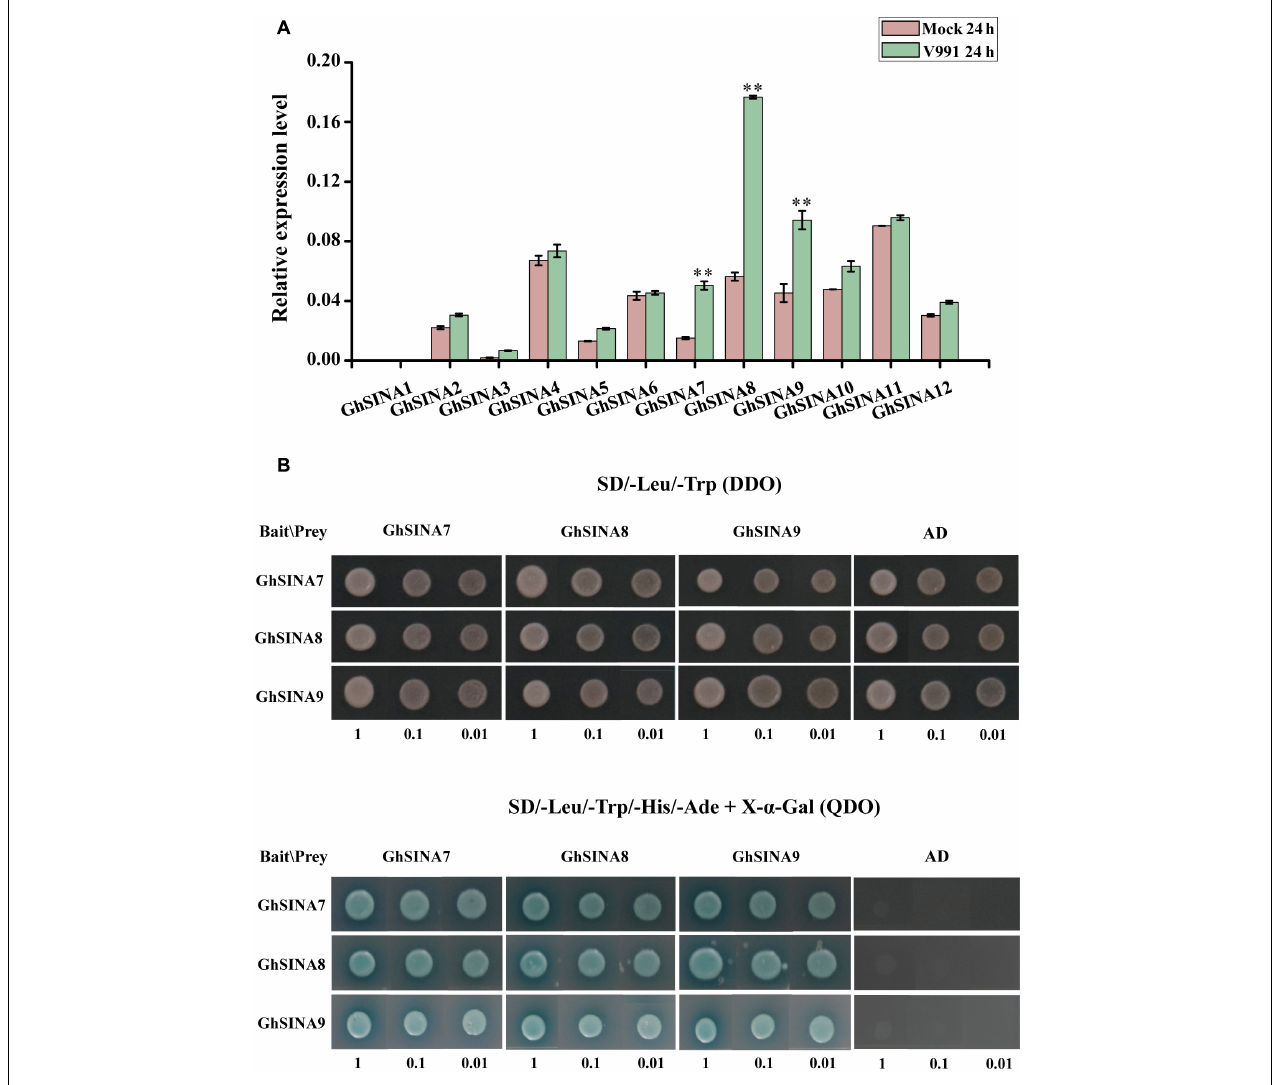
FIGURE 2 | Expression and yeast two-hybrid analyses of GhSINAs . (A) Expression levels of SINA genes in the resistant cultivar G. hirsutum cv. Zhongzhimian No. 2 roots at 24 h after inoculation with V. dahliae . Total RNAs were extracted from roots of 14-day-old seedlings at 24 h after V. dahliae infection. Error bars represent the SDs of three biological replicates. Cotton Histone3 was used as an internal control. Asterisks indicate statistically significant differences, as determined by Student’s t -test ( ∗∗ P < 0.01). (B) Yeast two-hybrid assays detected pair-wise interactions among the three GhSINA proteins (GhSINA7, GhSINA8, and GhSINA9). Transformed yeast cells with 10-fold serial dilutions were grown on SD/-Leu/-Trp DO (DDO) mediums and SD/-Leu/-Trp/-Ade/-His DO (QDO) mediums (containing X- α -gal) media. GhSINAs-BD/AD were used as negative